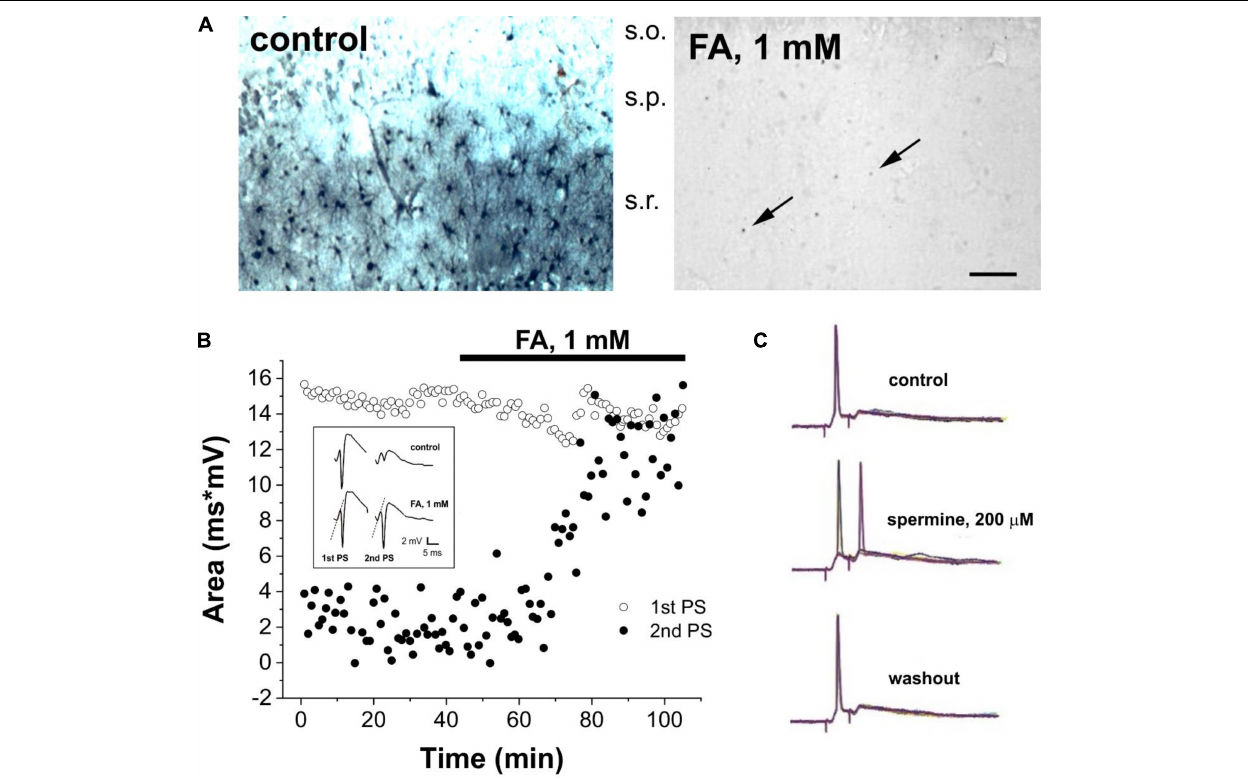
FIGURE 1 | Glial status determines neuronal behavior in Sprague-Dawley rat brain slices. (A) Immunocytochemical localization of spermine (SPM) in the CA1 region of the hippocampus under control conditions ( left ) and following 40 min perfusion with 1 mM of the gliotoxin monofluoroacetate (FA) ( right ). Note that in the left image, the pyramidal cell layer (s.p.) is rather empty, the stratum radiatum (s.r.) displays numerous SPM-positive astrocytes. In the right image, after perfusion with gliotoxin FA, SPM-positive astrocytes have completely disappeared in the stratum radiatum , leaving back only a few weakly positive cell bodies (arrows). S.o.: stratum oriens . Bar indicates 30 µ m for both images. (B) Time course of the area of first (open circles) and second (black circles) population spikes (PSs) recorded from CA1 pyramidal cell layer in response to paired-pulse stimulation (20 ms inter-pulse intervals each minute) in the presence of 1 mM FA. Individual field potential recordings are shown in the inset. (C) Average of 10 whole cell patch clamp recordings from CA1 pyramidal cells in response to paired-pulse stimulation (15 ms inter-pulse intervals each minute) under control conditions ( top ), in the presence of 200 µ M spermine ( middle ) and during washout ( bottom